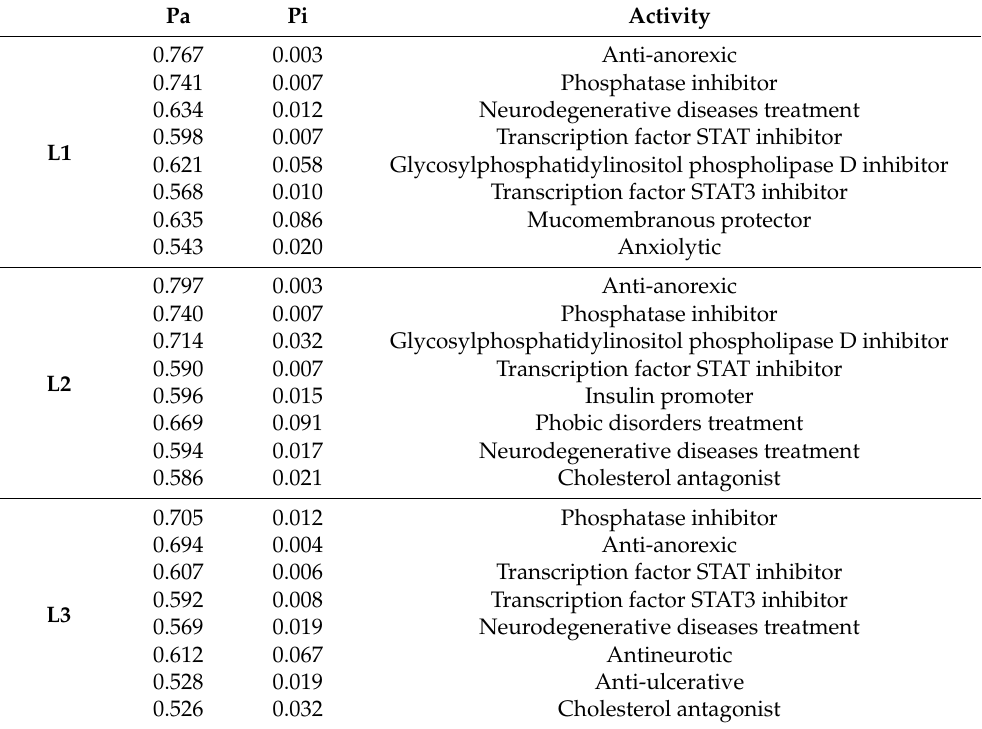
Table 4. Activity prediction results for three ligands: L1, L2, L3, where Pa is the probability to be active; Pi is the probability to be